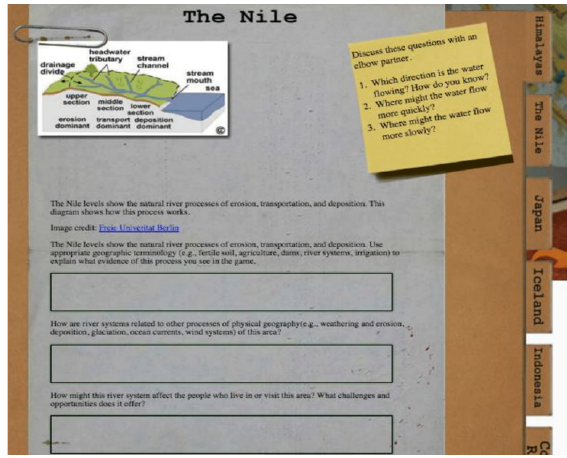
Figure 9. Natural processes activity.